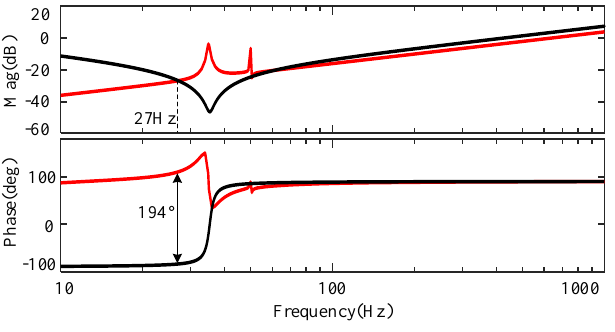
Figure 8. Bode diagram. Red line is the impedance in [23]. The black line is network impedance.